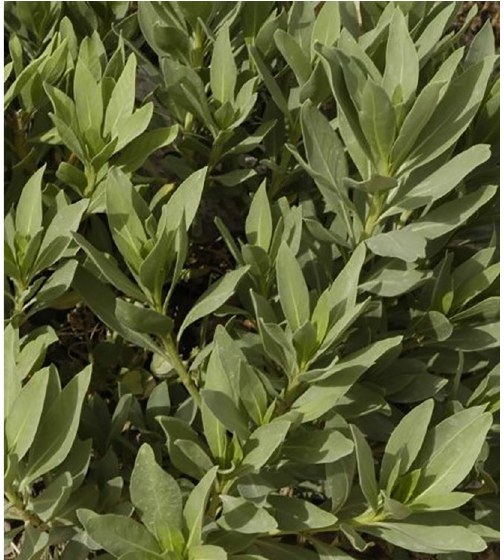
Figure 1. Photo of Rhazya stricta grown in natural